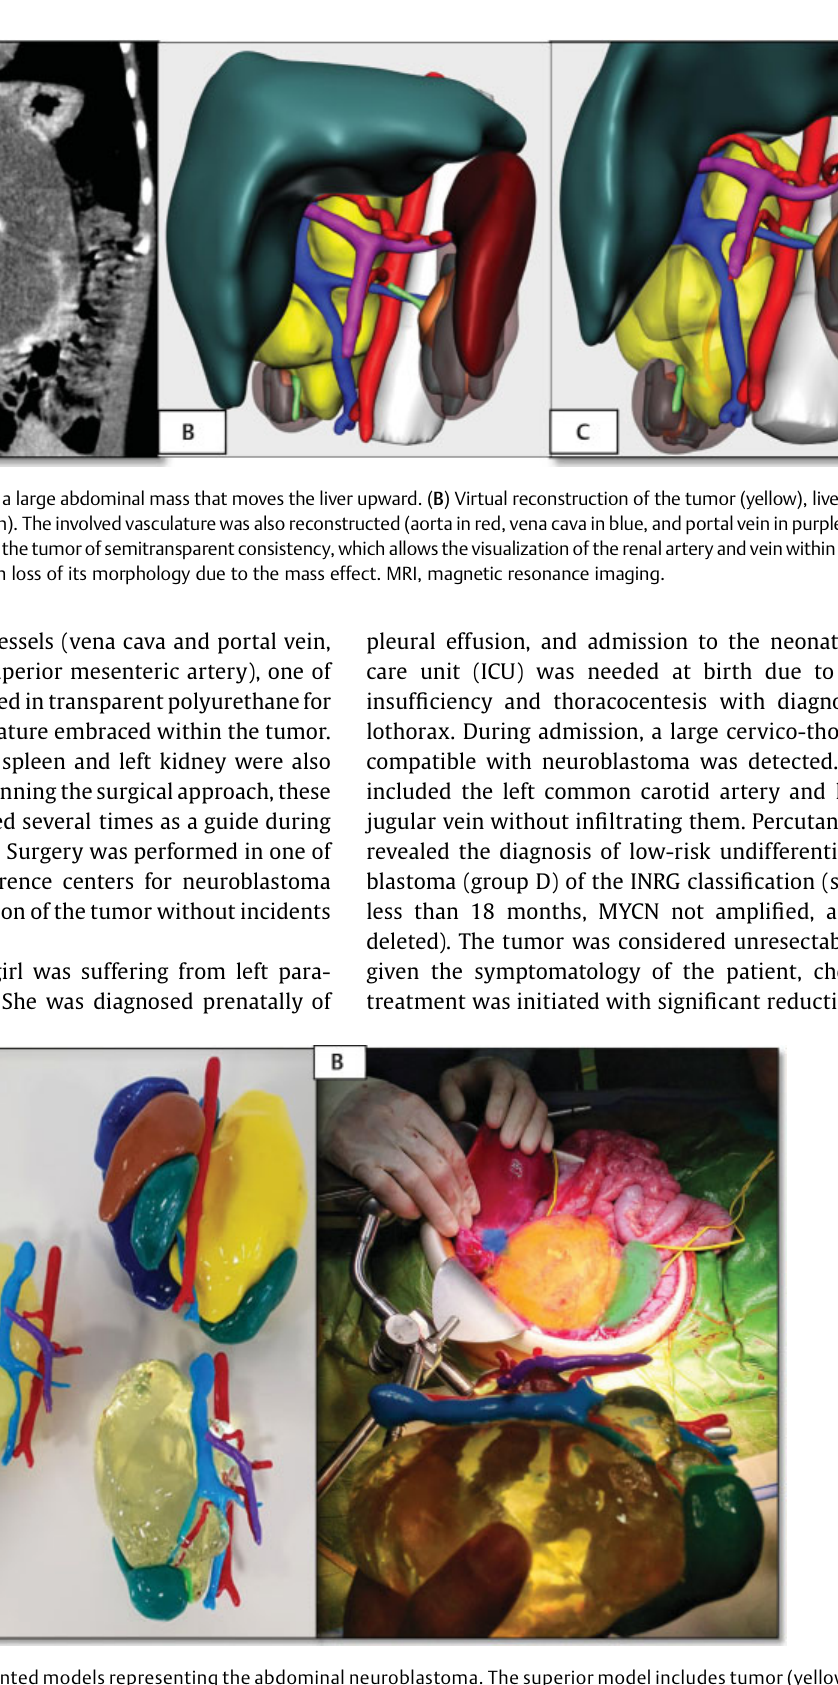
Fig. 6 Case 3. ( A ) Different printed models representing the abdominal neuroblastoma. The superior model includes tumor (yellow), aorta (red) and vena cava (blue) with its respective branches, liver (blue), both kidneys (green), and spleen (brown). The different structures are assembled by a magnetization system. The other two models represent the tumor and the relevant vascularity in different textures. ( B ) The model was consulted several times during the surgery. In the image, the correspondence between the model and the surgical anatomy is